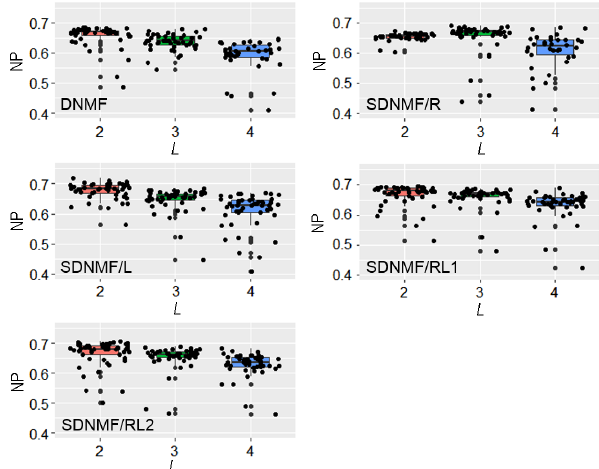
Fig. 3 Classification precision of our linear models on PIE-pose 27.0 dataset in terms of NP with different layer numbers ( L = 2, 3, and 4). The number of sub-bases in hidden layers was randomly extracted from certain exponential distributions. Then they were ranked to satisfy the relationship k lower layer > k higher layer . For example, for SDNMF/L with L = 3 and layer size = [ k 1 ; k 2 ; k 3 (cid:141) , the values of k 1 and k 2 were drawn from exponential distributions, with k 1 >>> k 2 , and k 3 is fixed to be 40. The experiments for SDNMF/L under each layer size was repeated 50 times, generating 50 NMI values. The rest experiments for the other models were performed in the same